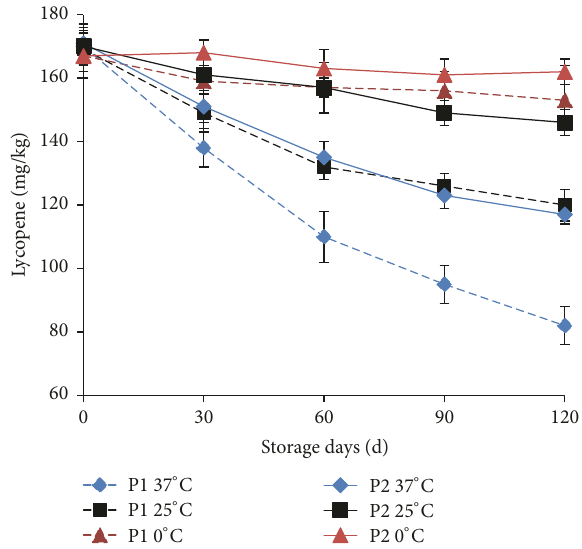
Figure 2: Changes of lycopene in THPS during storage. The experimentswereperformedintriplicate,andresultswereexpressed as the means ± standard deviation